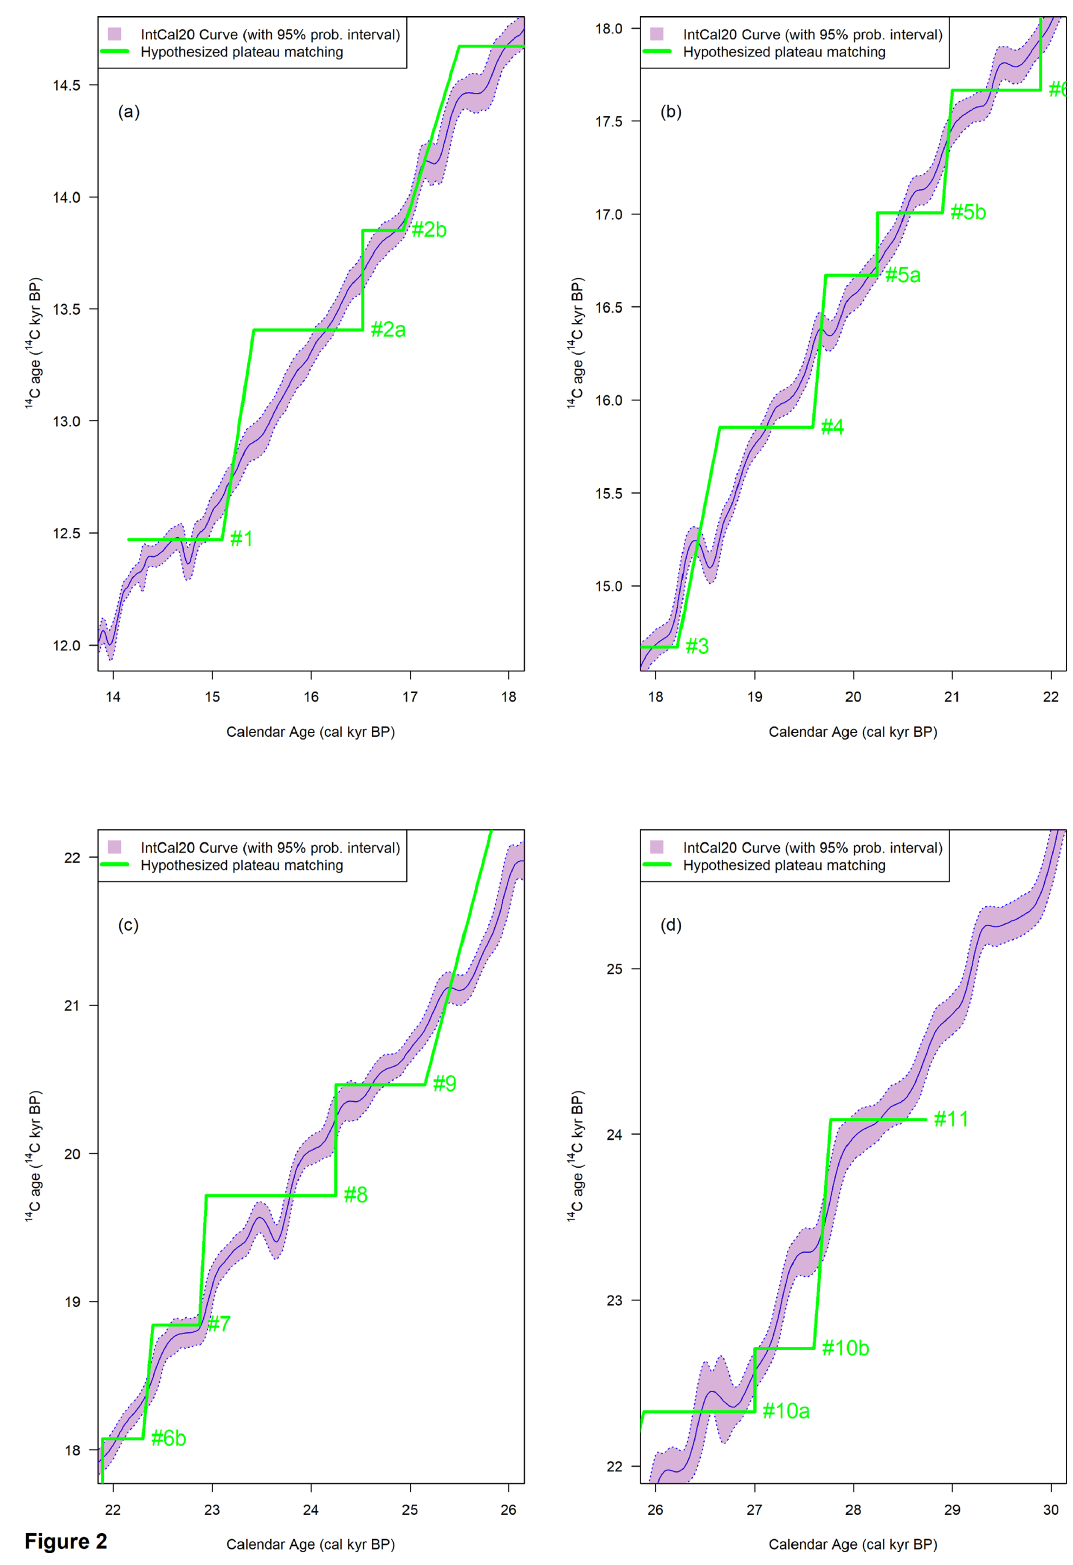
Figure 2. The thin solid purple line shows the pointwise posterior mean of the IntCal20 curve, with the shaded interval representing the 95% posterior predictive probability interval (Reimer et al., 2020; Heaton et al., 2020b). Superimposed thick green lines indicate the 15 atmospheric plateaus with their numbering as listed in Table 1 of Sarnthein et al.